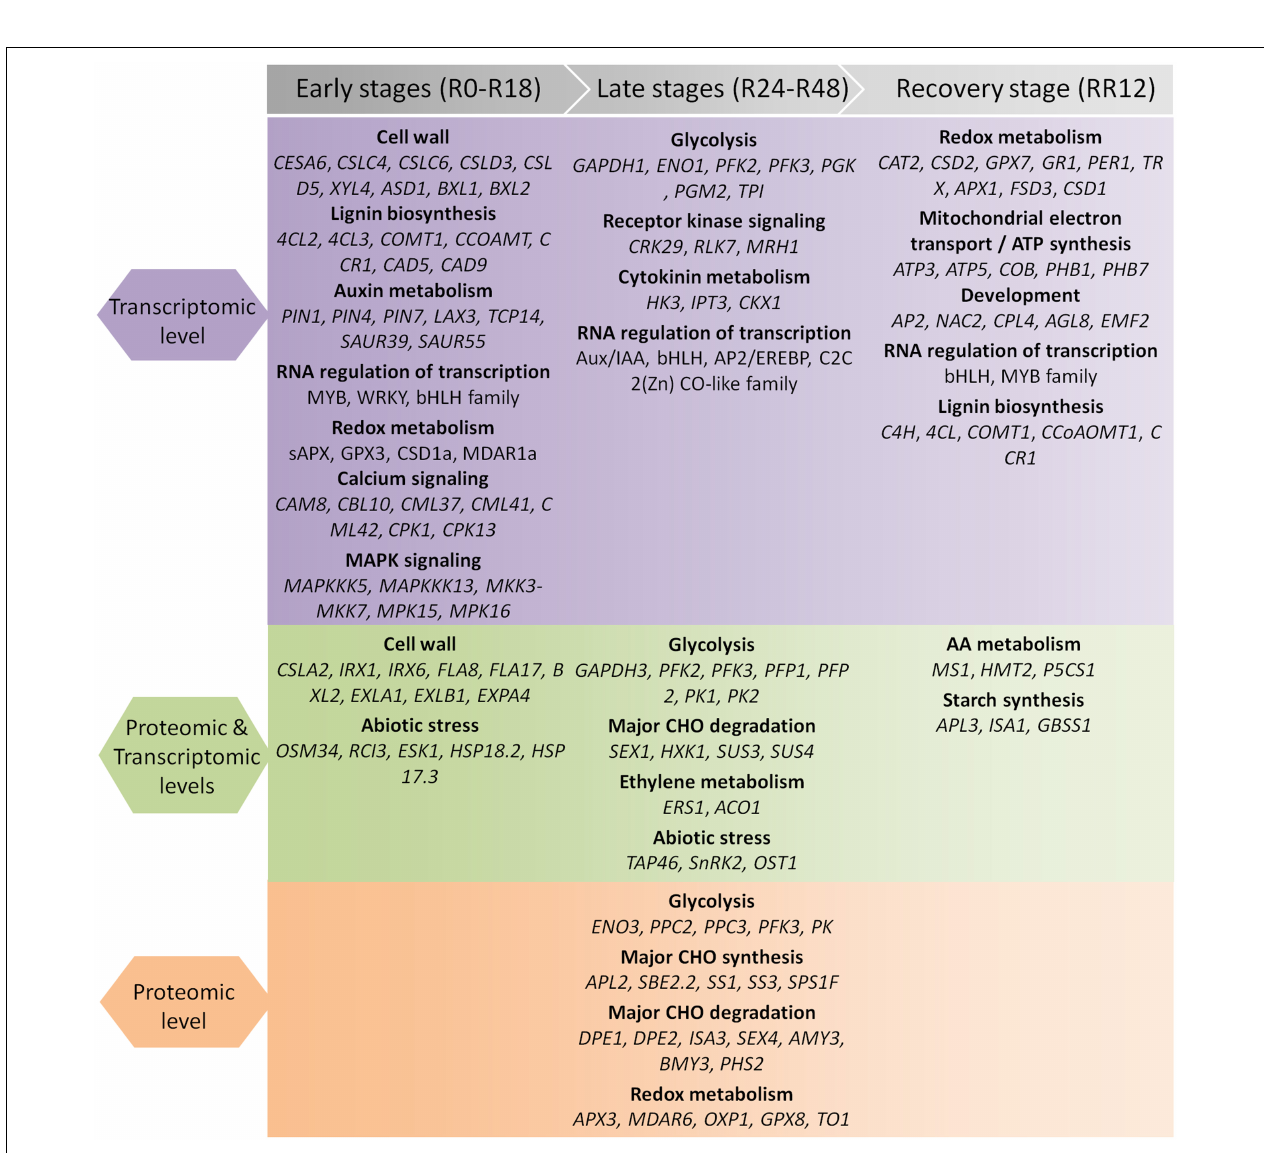
FIGURE 3 | Summary of genes and pathways identified by integrated transcriptomic and proteomic analysis during flooding stress. The flooding treatment is divided into the early, late, and recovery stages.